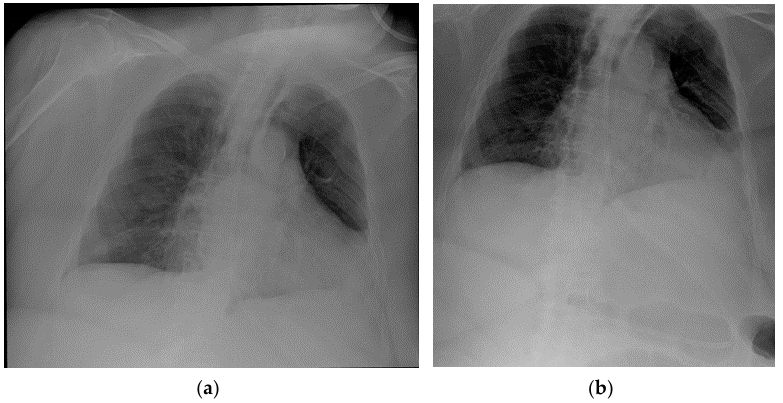
Figure 23. Images of a misplaced NG tube, whose tip reaches the pre-pyloric region after looping at the greater curvature of the stomach. Note that such a misposition was not visible in the regular chest projection ( a ), making an extended view on the upper abdomen therefore necessary ( b ).